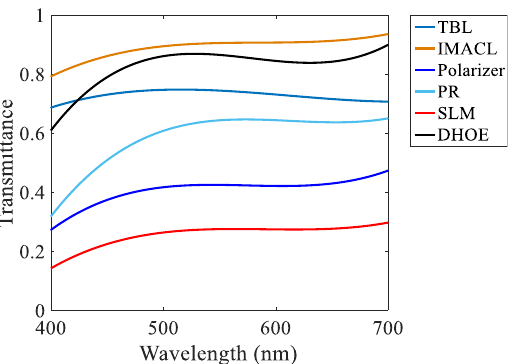
Figure 9. Measured luminance distribution of ( a ) DHOE with diffusing angle of 10 diffusing angle of 60 . °